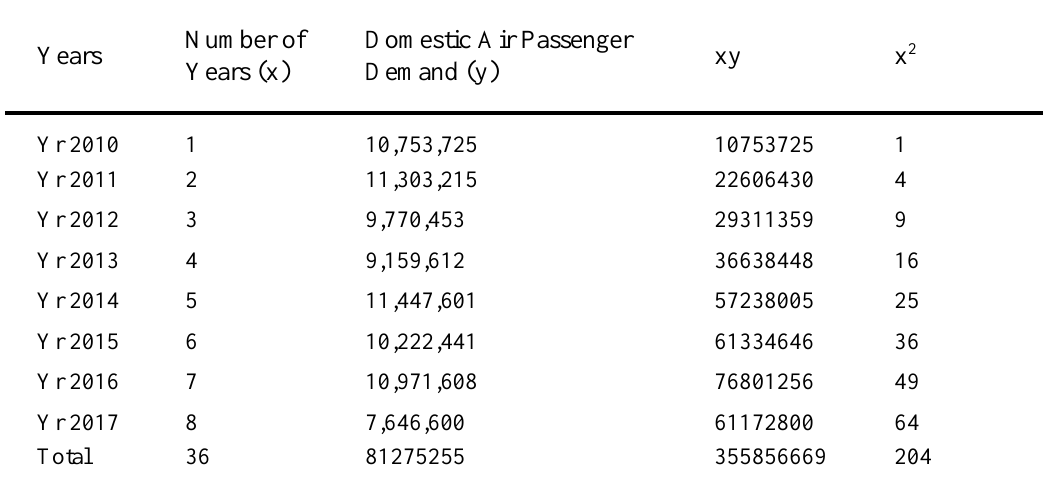
Table 2. Details of Regression